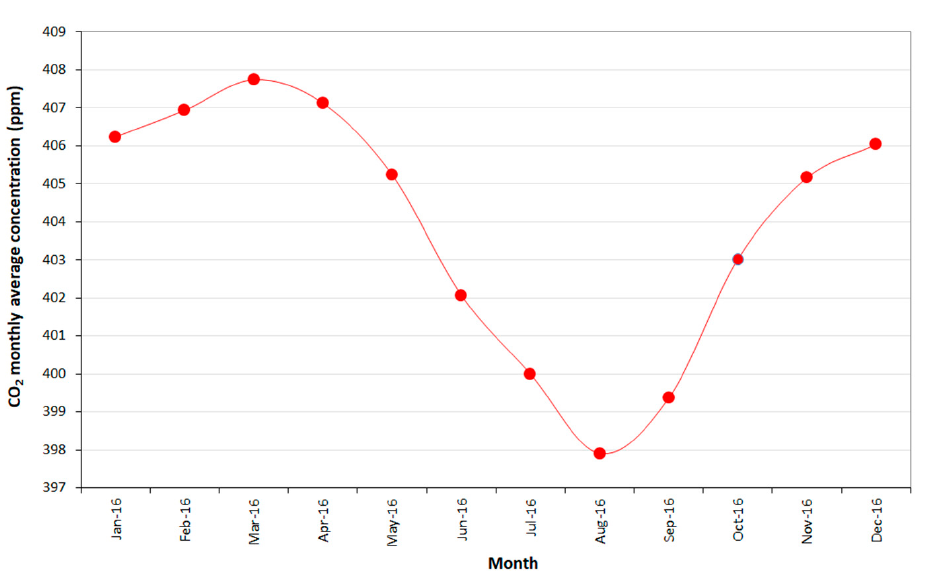
Figure 7. Monthlyaverage CO 2 concentrationsforthe year2016. Thedotsinredrepresentthebackground Figure 7. Monthly average CO 2 concentrations for the year 2016. The dots in red represent the monthly averages. background monthly averages.